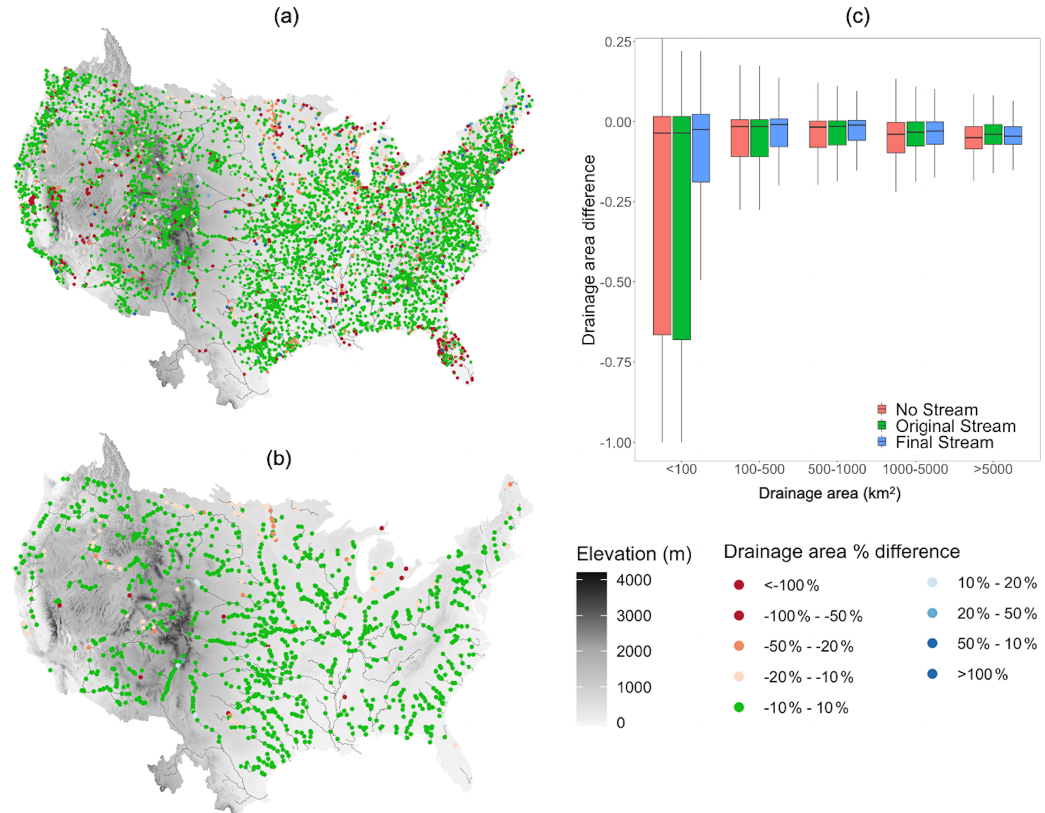
Figure 7. Drainage area comparison between processed with final-order stream network and USGS gage measurements. (a) All gages for comparison; (b) gages with drainage area over 5000km 2 . (c) The boxplot of drainage area difference with different stream networks grouped by drainage area